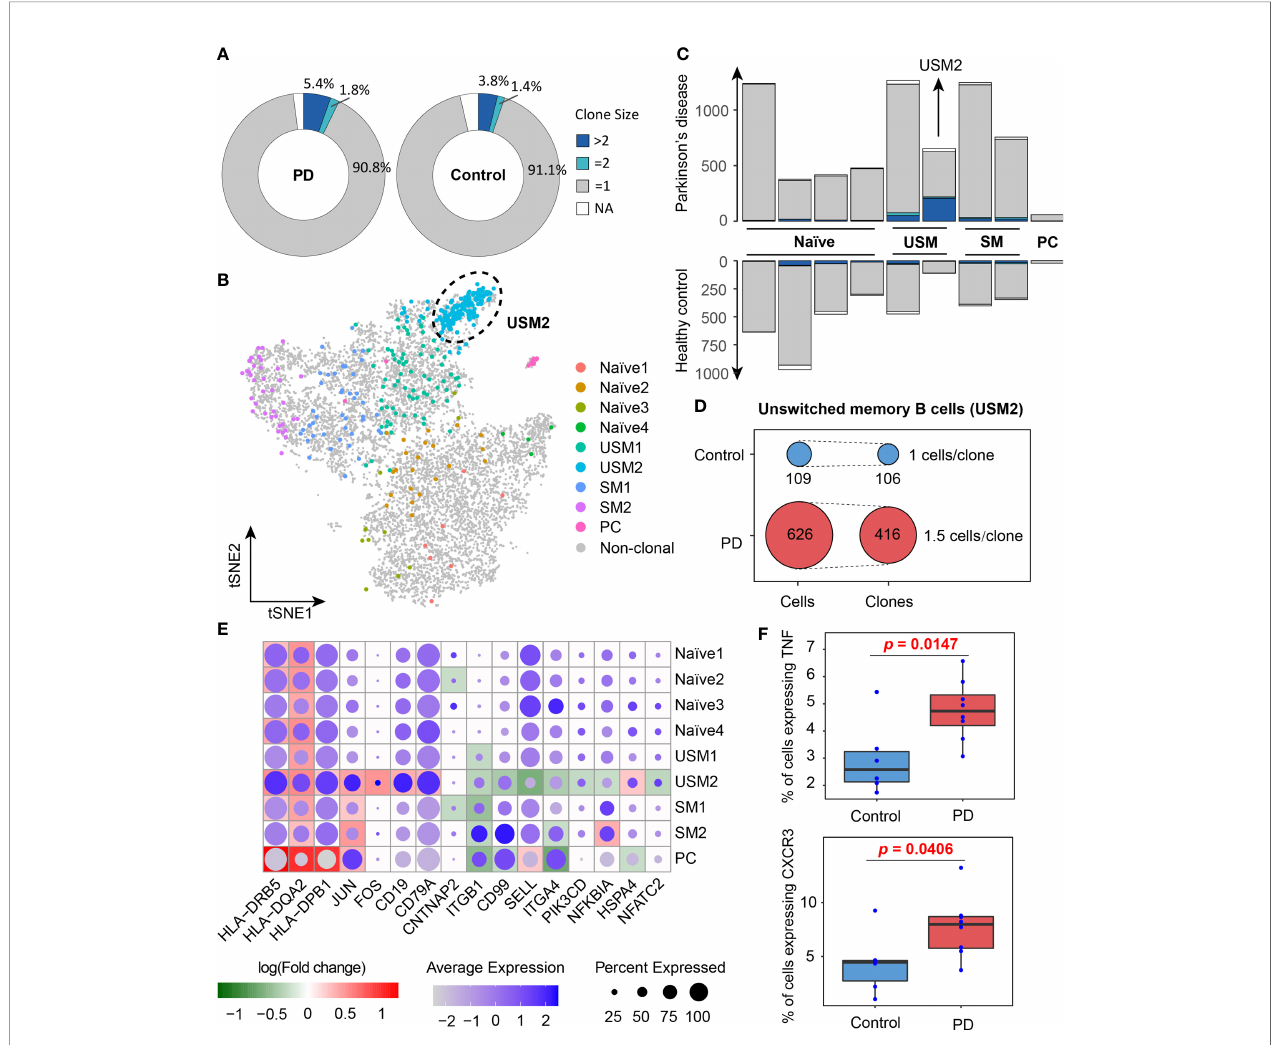
FIGURE 4 | Clone expansion of B cells in Parkinson ’ s disease. (A) Pie charts show the distribution of clonotypes grouped by clone size (NA, = 1, = 2, >2, NA represents cells with no BCR sequence detected). (B) tSNE plot shows the distribution of clonally expanded B cells. (C) Bar plots show the distribution of clonotypes grouped by clone size in PD patients and healthy controls. (D) Clonotype diversity of unswitched memory B cells (USM2) in PD patients and healthy controls. (E) A global view of the differentially expressed genes related to B cell receptor signaling pathway in each cluster. The size of the dot represents the percentage of cells expressing the gene in each cluster, while the color represents the average gene expression value. Background heatmap shows the log- transformed fold-change of DEGs between PD patients and healthy controls. (F) Box plots show the percentages of B cells expressing TNF and CXCR3 in PD patients and healthy controls. Each dot represents a